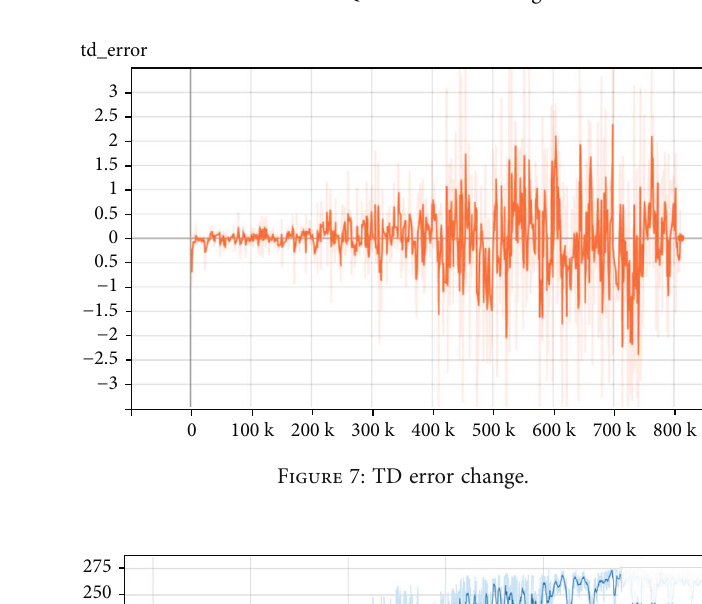
Figure 6: Q network loss change.